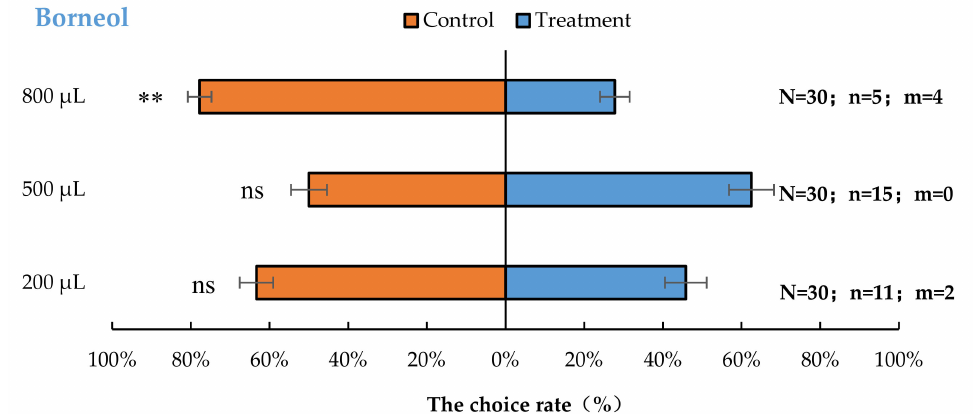
Figure 3. Behavioural responses of A. bungii females to different quantities of borneol. Note: N = number of responsive A. bungii ; n = number of A. bungii females choosing the treatment; m = number of A. bungii that made no choice. ns = no significant difference; ** = significant dif- ference at the 0.01 level (the binomial test).